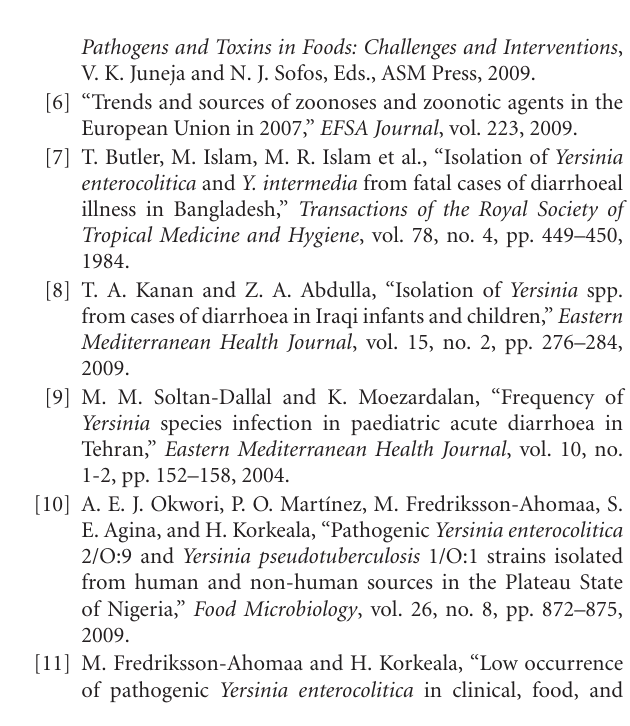
Figure 3: Methods used for epidemiological studies of Y. enterocolitica -2. DNA colony hybridization assays [51, 65–70]; PCR based detection methods [11, 71–81]. ( inv : gene for invasin, an outer membrane protein that is required for e ffi cient translocation of bacteria across the intestinal epithelium; ail : gene for adhesin, an outer membrane protein that may contribute to adhesion, invasion and resistance to complement-mediated lysis; yst : gene for heat-stable enterotoxin that may contribute to the pathogenesis of diarrhea associated with acute yersiniosis; virF : gene for transcriptional activator; yadA , gene for Yersinia adhesin A; PFGE: pulsed field gel